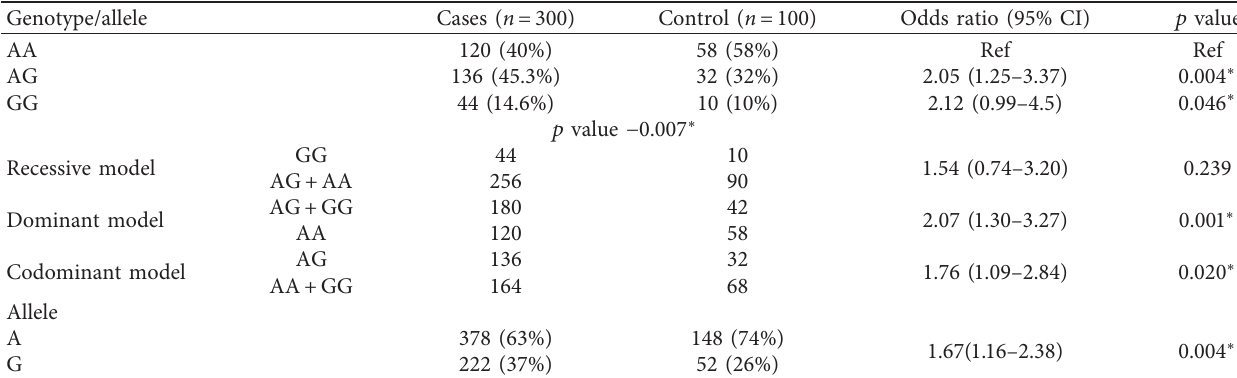
Figure 2: Graphical representation of clinicopathological characteristics of T2DM patients and controls. Table 2: Genotypic and allelic distribution and association analysis of KCNJ11 rs5210 gene polymorphism and risk of T2DM under different genetic